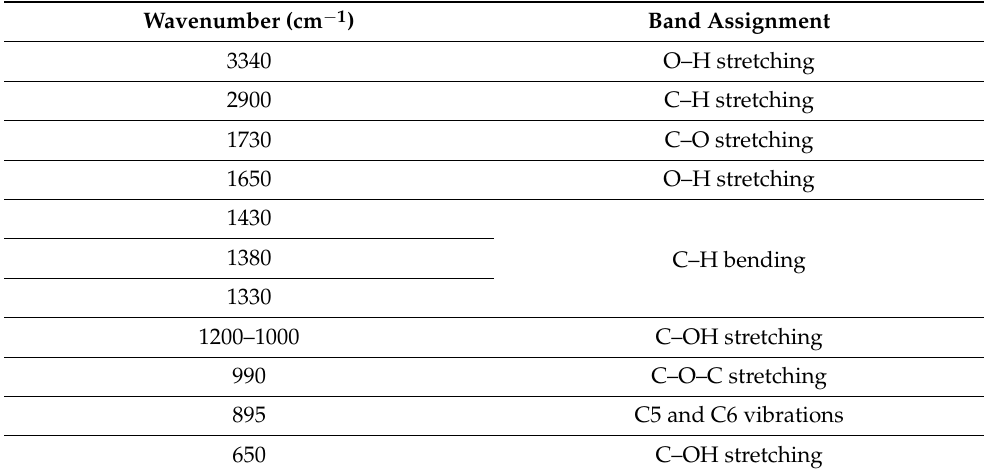
Figure 2. FTIR spectra of native and mercerized cellulose: ( a ) pristine; ( b ) after PEG modification. Table 2. Characteristic FTIR bands.